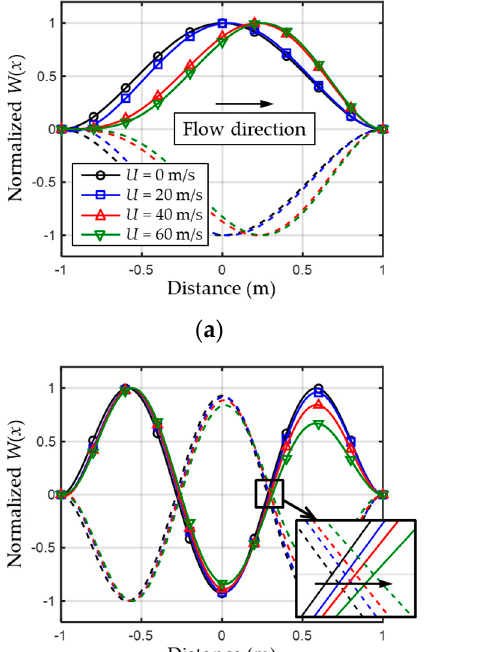
( d ) Figure 7. Numerical mode shapes of the fluid-conveying pipe when the flow velocity increased: ( a ) 1st, ( b ) 2nd, ( c ) 3rd, and ( d ) 4th mode shapes.